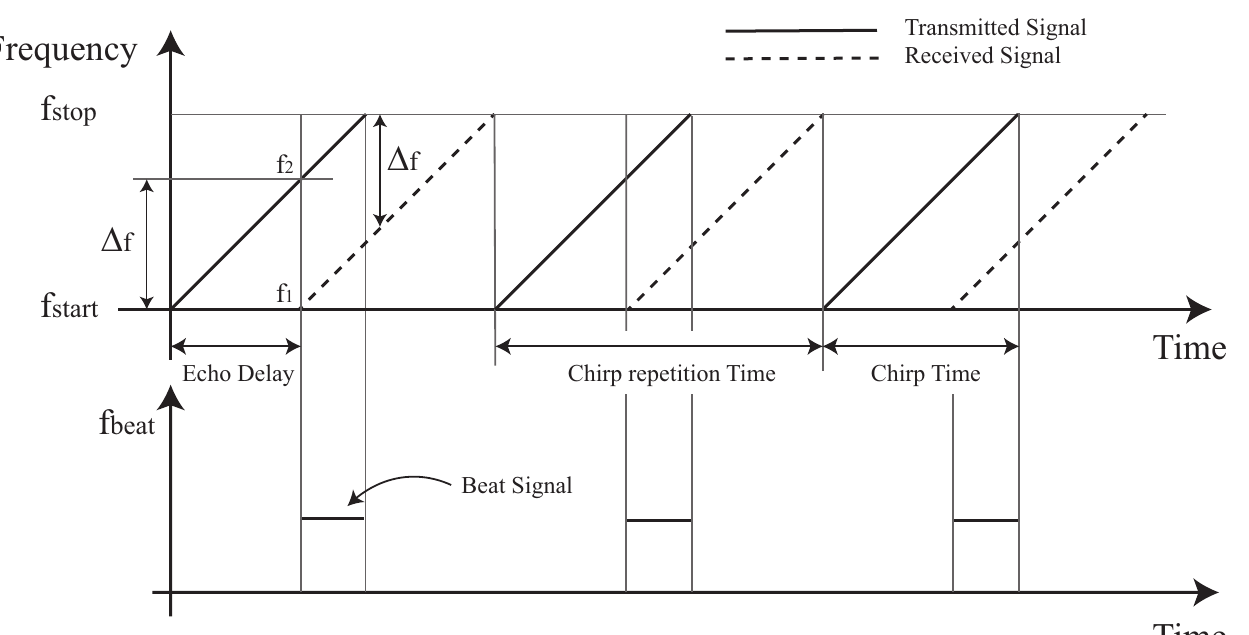
Figure 2. Transmitted and received chirps in a Radar